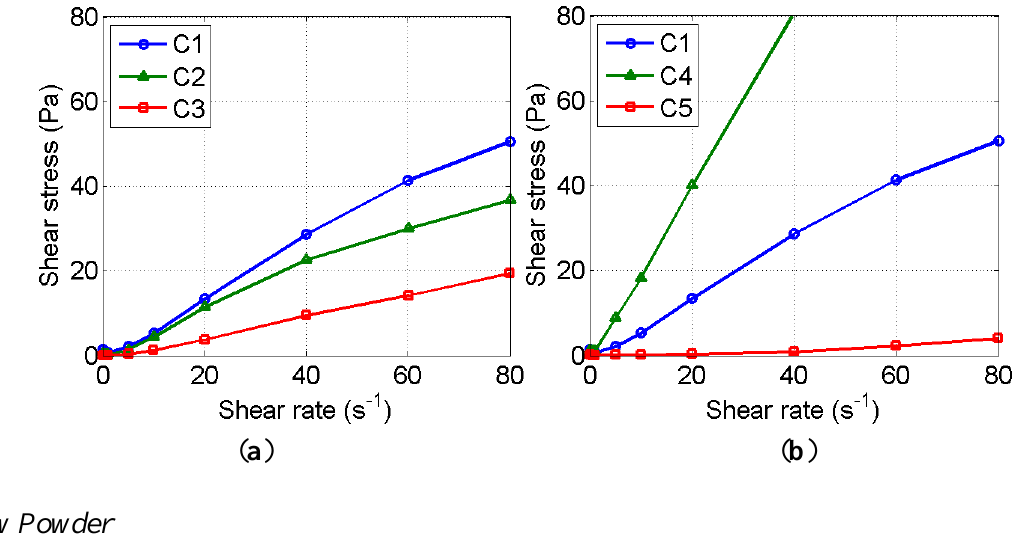
Figure 3. Flow curves of the samples according to the ( a ) different HRWRA dosage and ( b ) different w